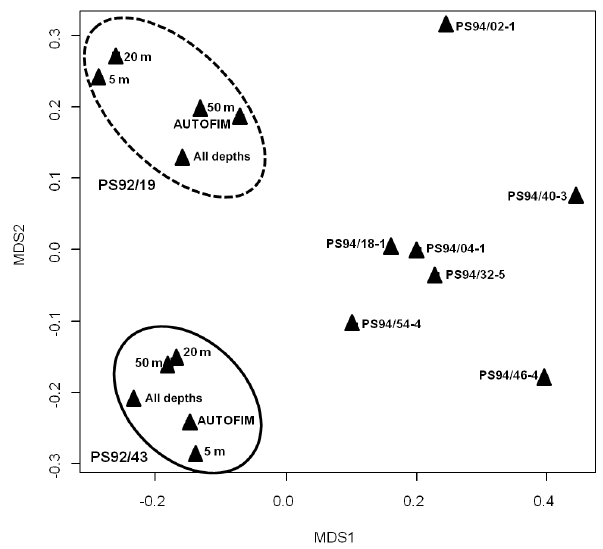
Figure 3. MetaMDS plot (non-metric multidimensional scaling plot) of ARISA fingerprints generated from samples collected via Niskin bottles coupled to a CTD rosette and AUTOFIM. The closer the samples are located to each other in the metaMDS plot, the more similar the ARISA profiles of the samples are. The label of the samples gives information on the cruise leg (PSXX) and the station (/XX). Samples were collected during expeditions PS92 and PS94 of RV Polarstern to the Arctic Ocean during summer 2015. The samples collected during PS94 serve as an outgroup in this analy-